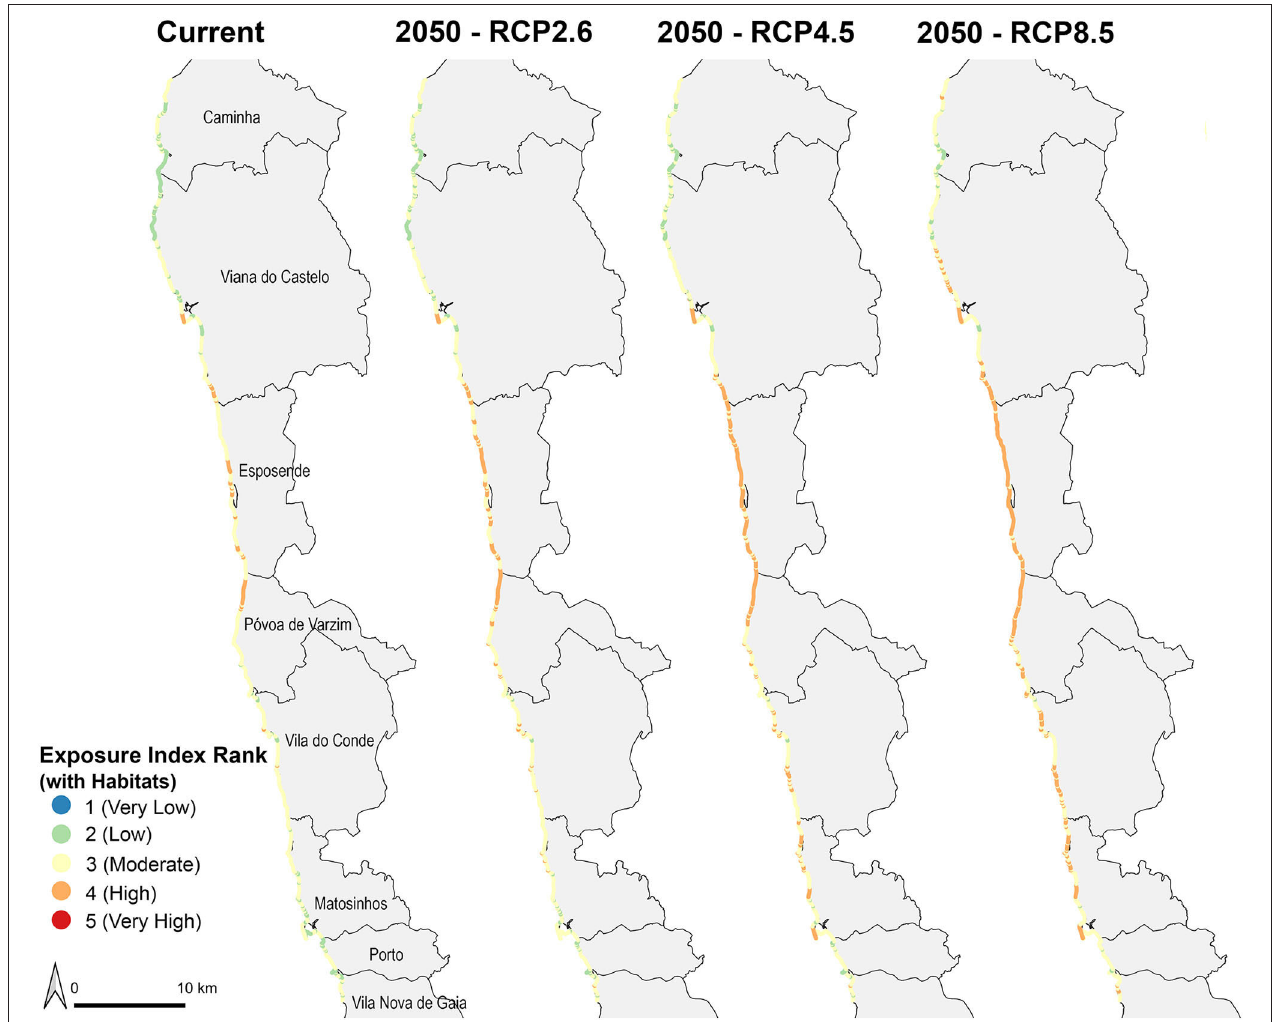
FIGURE 3 | Exposure Index values for the Current scenario and under the different RCP scenarios for 2050 for the northern coast of Portugal, with the presence of coastal habitats. RCP, Representative Concentration Pathway.